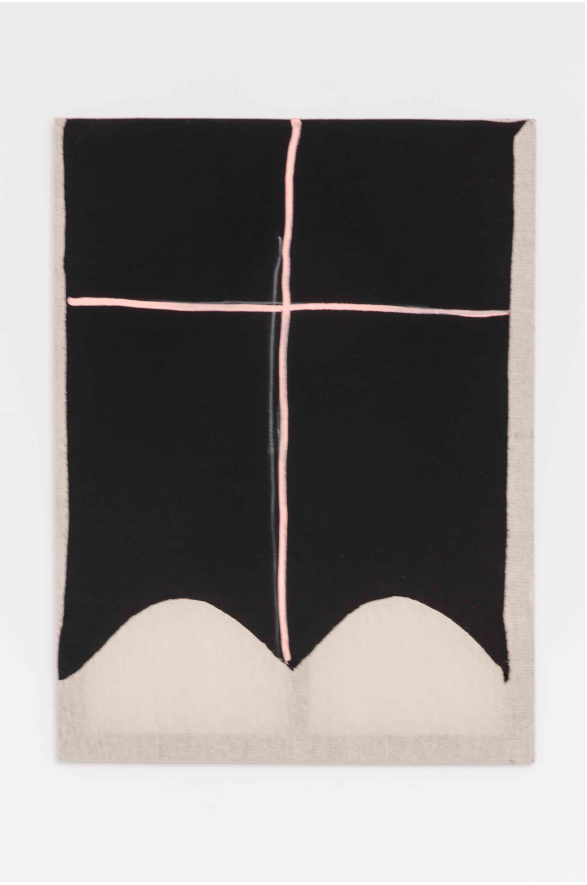
Figure 4: Sarah Pettitt, Sunset , 2016, Dust sheet, cotton, acrylic and chalk, 100 x